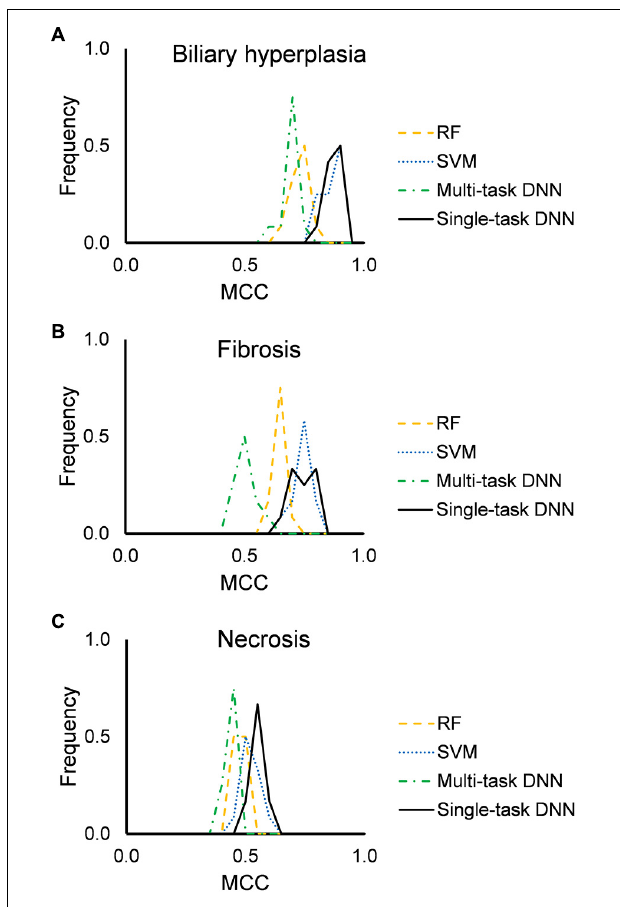
FIGURE 2 | Performance of RF, SVM, single-task DNN, and multi-task DNN models based on cross validation studies. (A–C) results for biliary hyperplasia, fibrosis and necrosis,